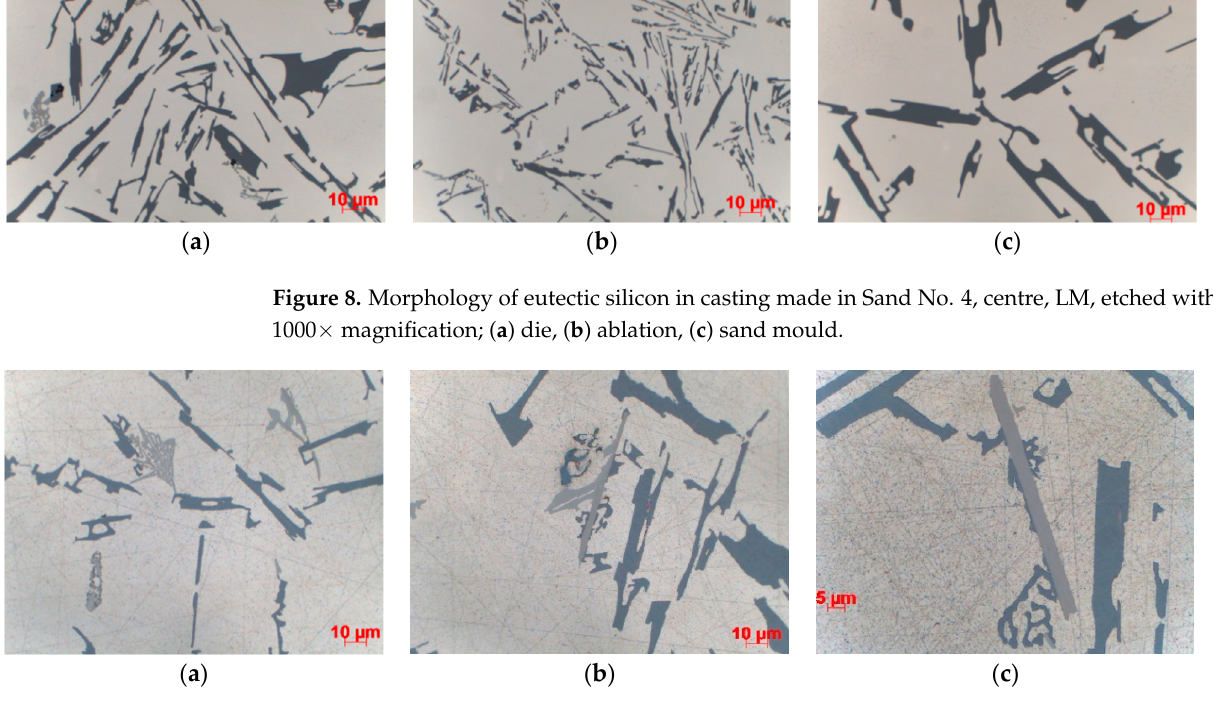
Figure 9. Phase constituents of the microstructure of casting made in Sand No. 4, LM; ( a ) ablation— top, ( b ) sand—top, ( c ) sand—centre.